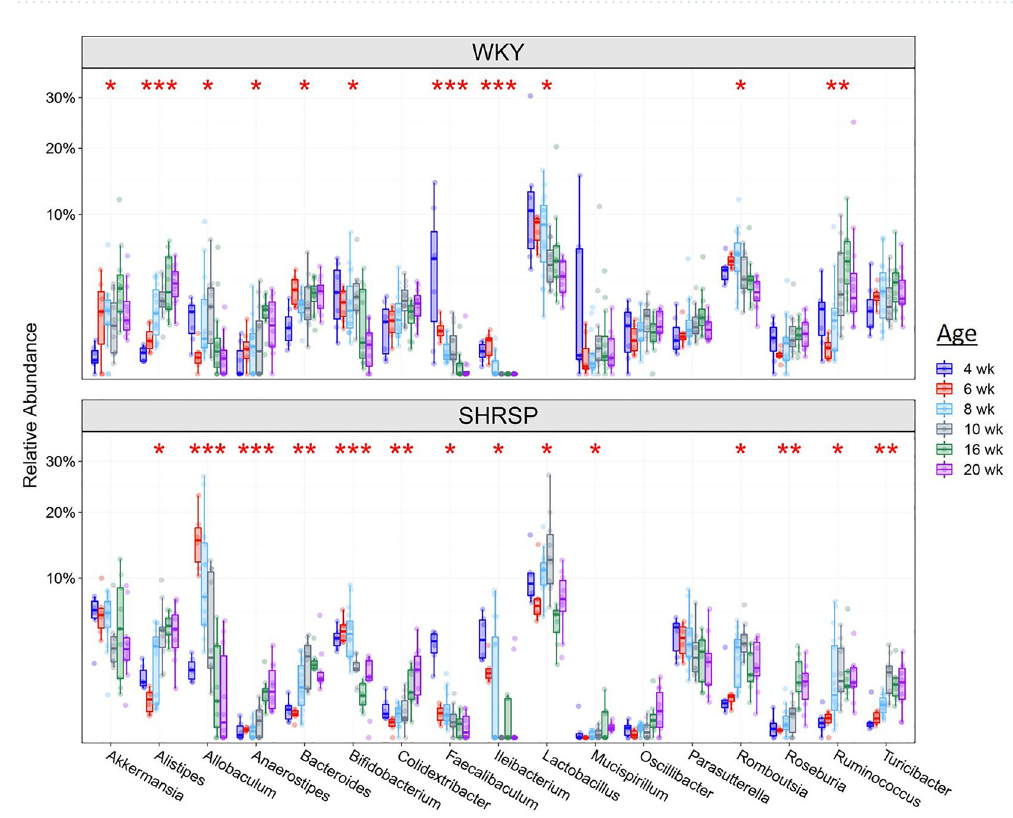
Figure 5. Relative abundance of genera in WKY (top) and SHRSP (bottom) during aging from 4 to 20 weeks. (n = 6–15) *, **, and *** p < 0.05, 0.01, and 0.001 over age respectively using Mann–Whitney U test with FDR corrected for multiple comparisons. Only genera with relative abundance ≥ 0.5% are